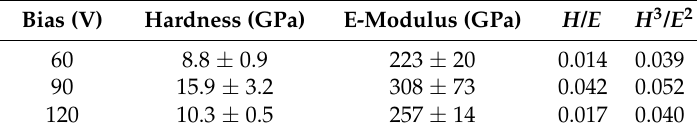
Table 3. Effect of the bias voltage on mechanical properties of the